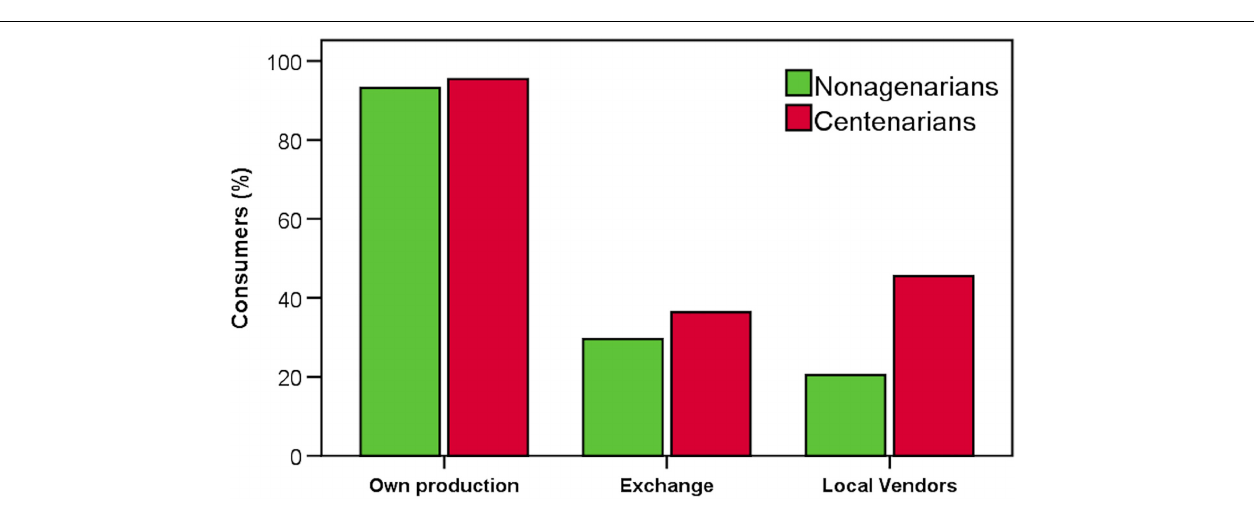
FIGURE 4 | Percentage of subjects consuming foods produced by themselves, exchanged with other locals, or bought from local